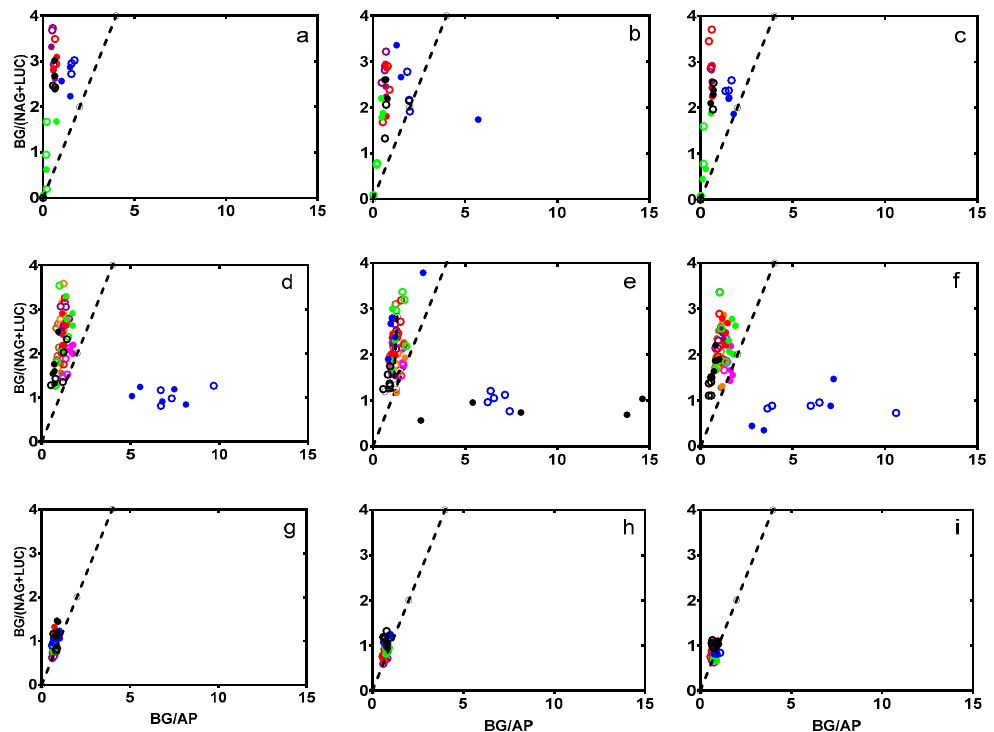
Figure 4. Ecoenzyme activity of C:N ( y -axis) as a function of C:P ( x -axis) over time, with a dashed line representing the 1:1 reference. Treatments are organized by column: ( a , d , g ) no compost, ( b , e , h ) dairy compost, and ( c , f , i ) poultry litter compost. C, N, and P activity were measured by BG: β -1,4-glucosidase, NAG: β -1,4-N-acetylglucosaminidase plus LUC: L-leucine aminopeptidase, and AP: phosphatase, respectively. Each row represents a study year: ( a – c ) 2015, ( d – f ) 2016, and ( g – i ) 2017. Within each panel, colors represent the sampling times within a year: (1) black; (2) blue; (3) green; (4) red; (5) purple; (6) orange; (7) fuchsia; (8) brown. Fields are labeled as Lilac soil (open circle) and Wheelock soil (closed circle).